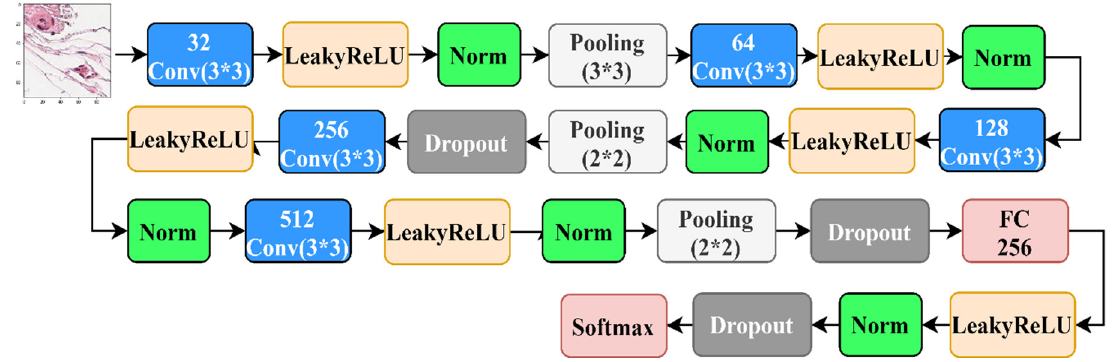
Figure 6. The architecture of Nguyen et al. [20].